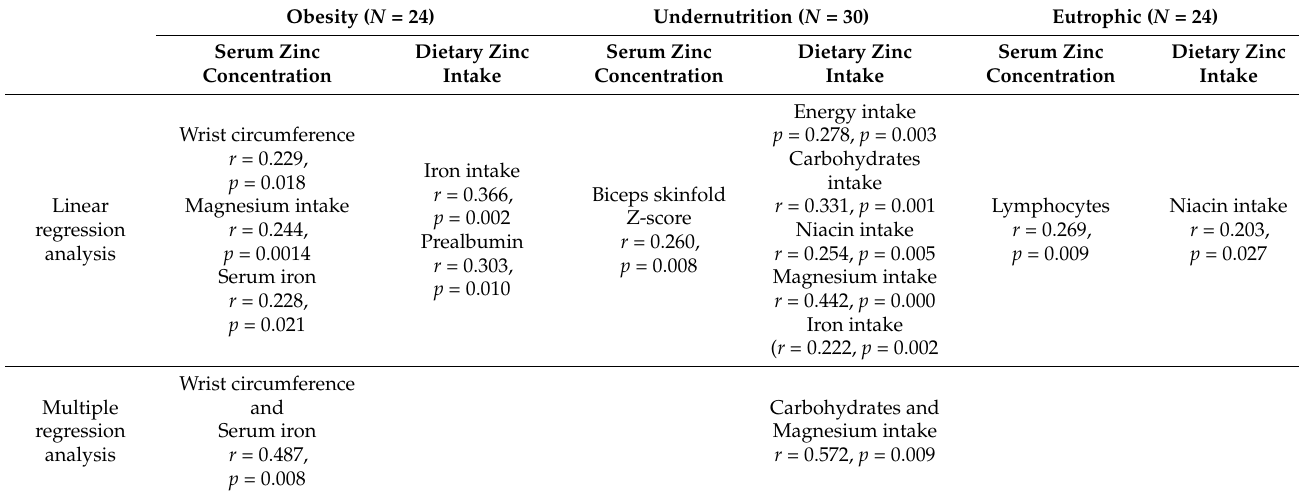
Table 2. Regression serum zinc, dietary zinc intake by nutritional parameters in both groups ( N =